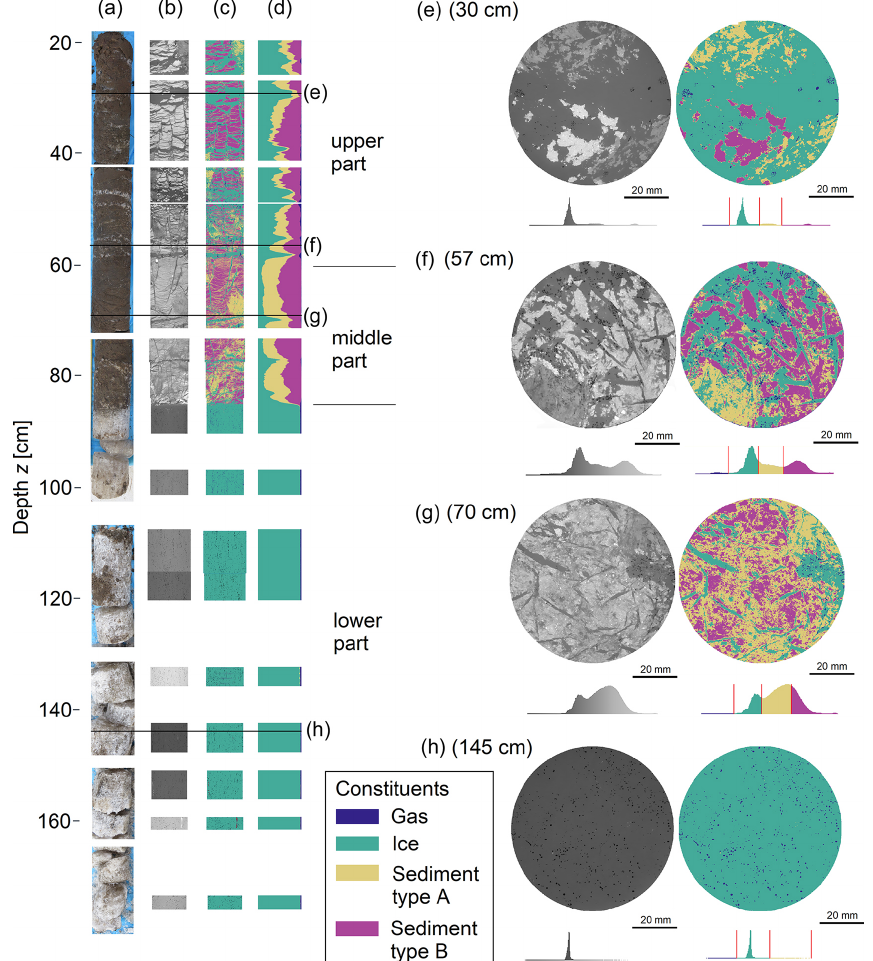
Figure 1. Overview of the studied permafrost core (a–d). Photography taken after drilling (a); absorption images from CT scanner after preprocessing (b) and after segmentation (c); volumetric contents of gas, excess ice, and sediment types A and B (d). The right part (e–h) shows exemplary horizontal slices of the preprocessed and segmented CT images, as well as the histograms of greyscale values, which are indicative of the constituents’